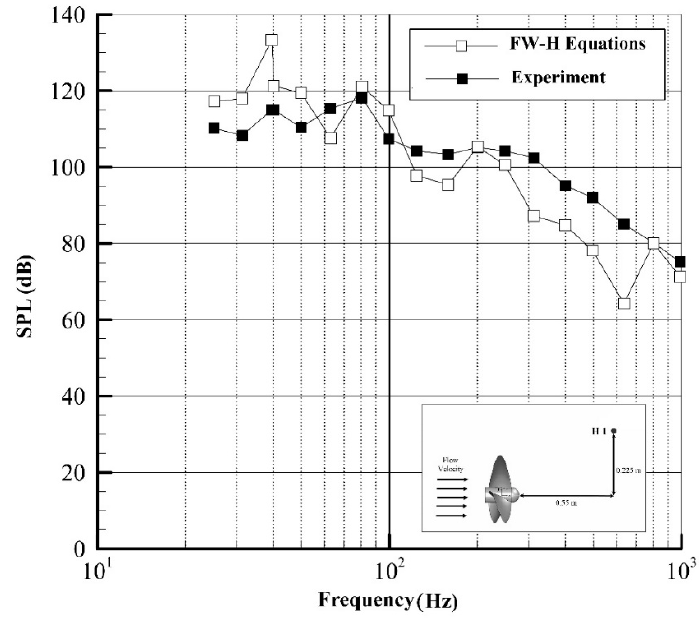
Figure 13. Validation of FW-H code results.